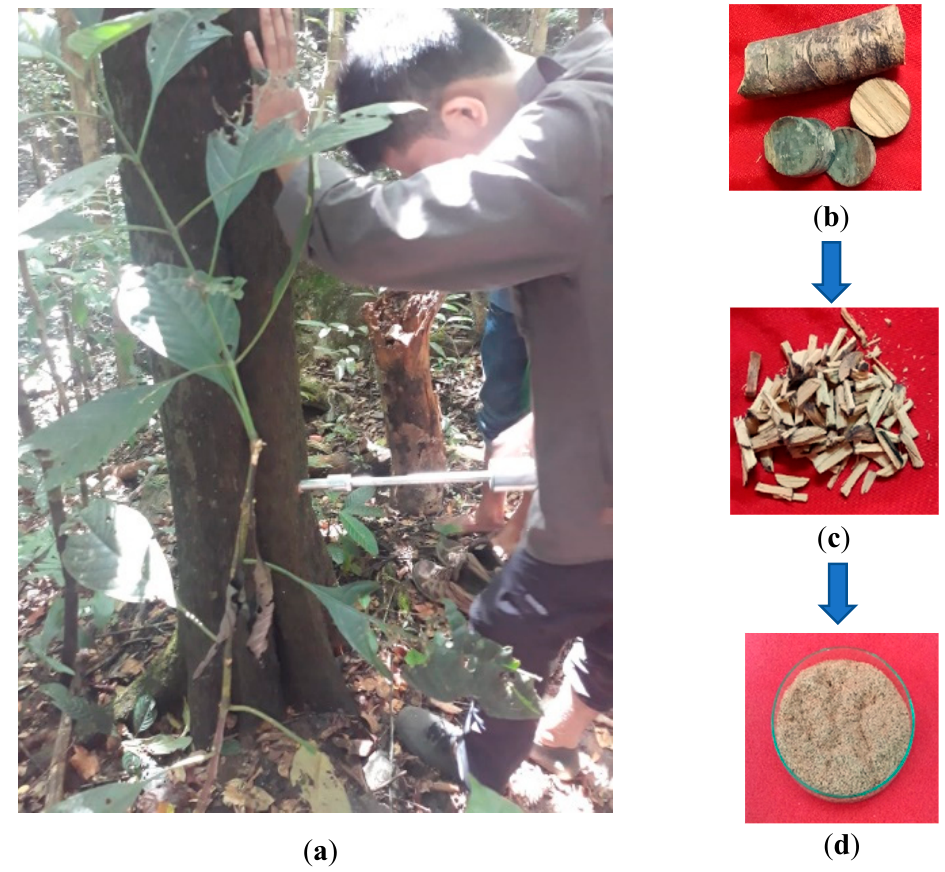
Figure 2. ( a ) Samples of ebony wood sample were taken from the trees using a Pickering Punch ® tool (Agroislab, Welburn, UK); ( b ) cylindrical wood sample, ( c ) wood chip samples, ( d ) wood meal samples (40–60